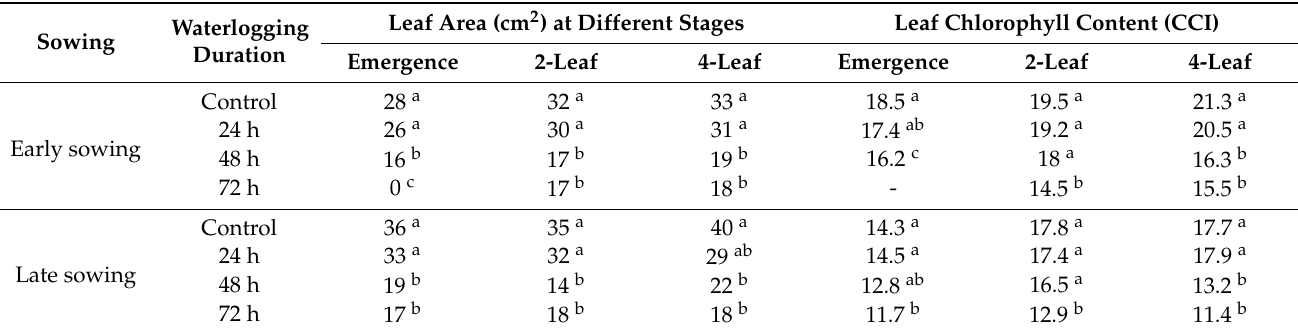
Means with the same letter (a, b and ab) in a column are not significantly different. Means are the average of three repli- cations.